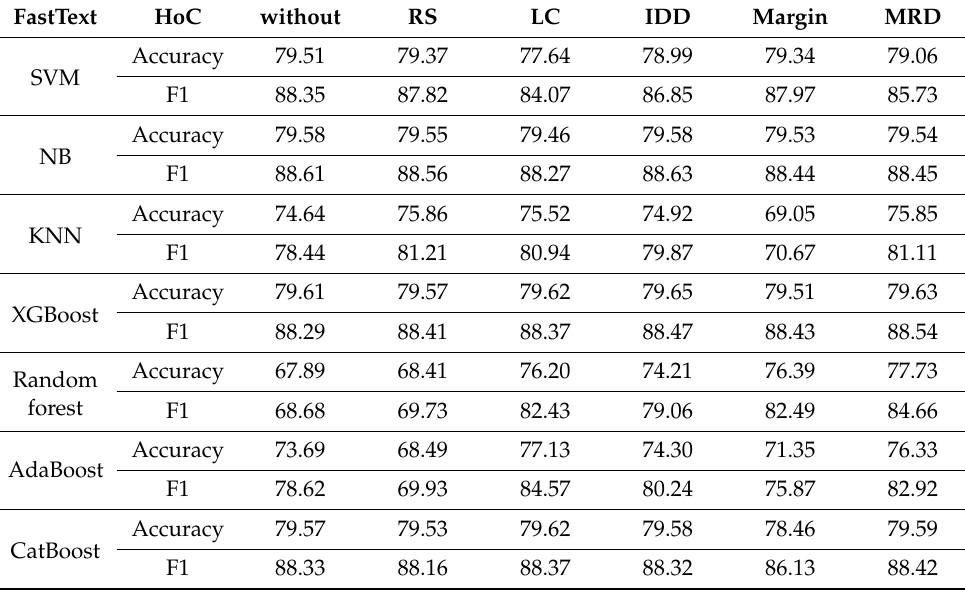
Table 7. Comparison of results with and without AL methods (FastText) for ChemProt